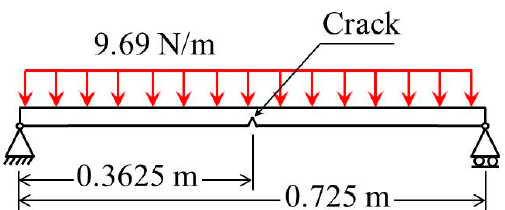
Figure 1. Two-dimensional representation of the three-dimensional cracked rotor model showing static loading.